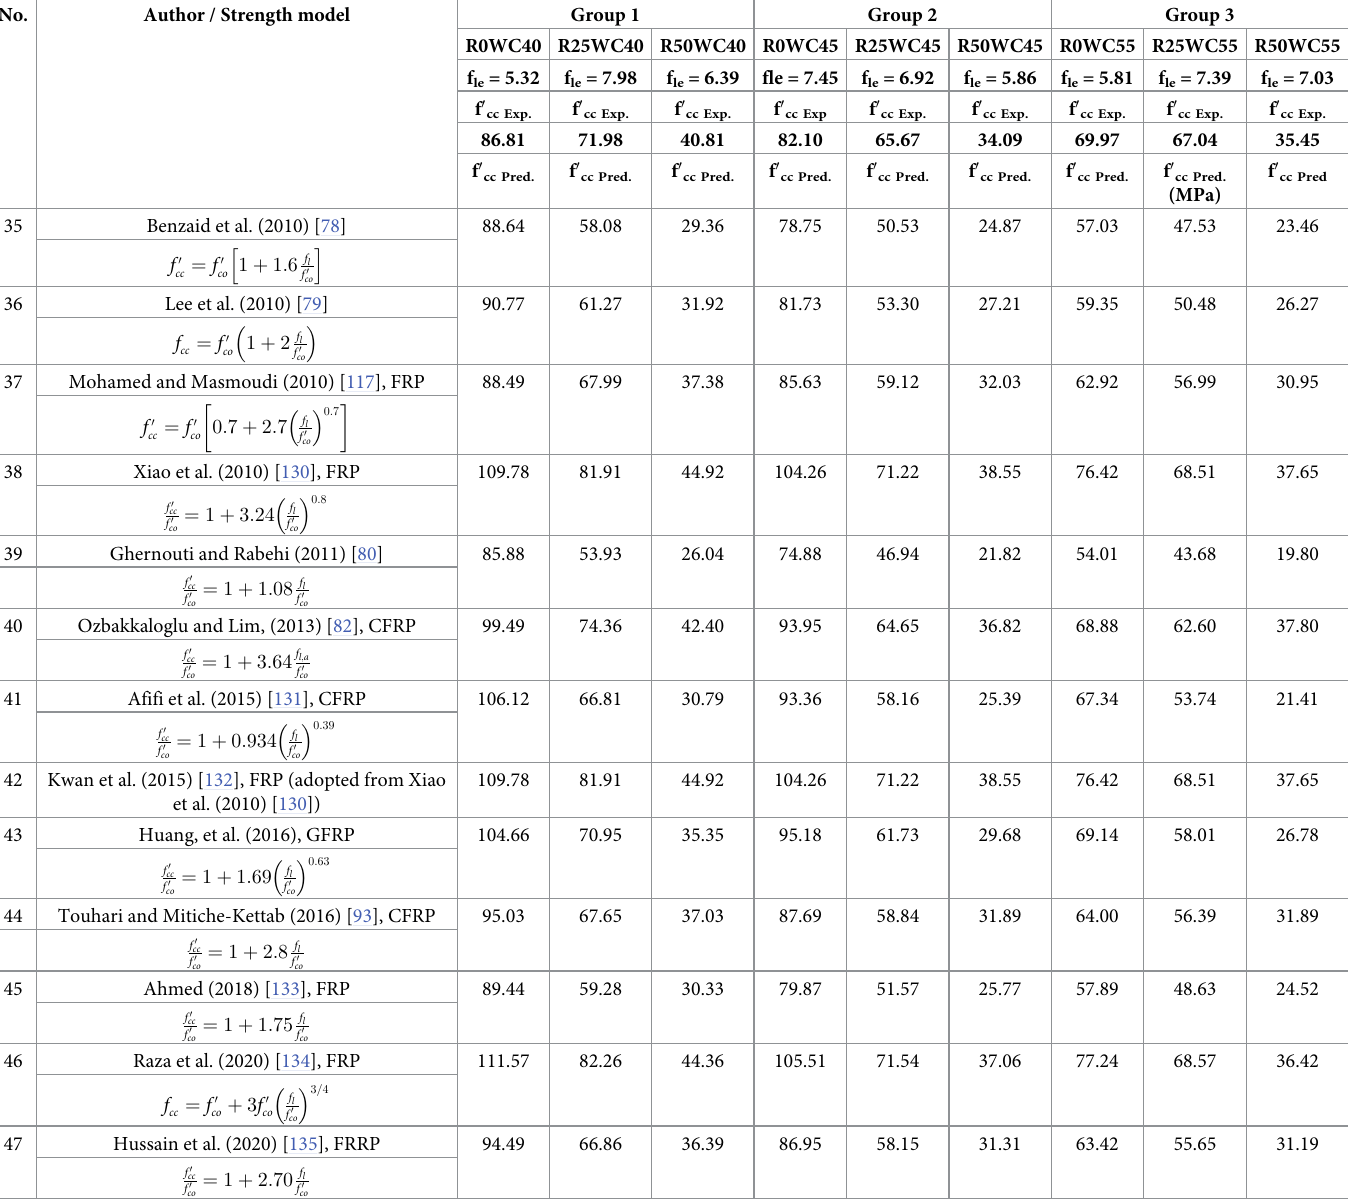
substitution. The enhancement ratio ranged from 8% to 190%. 3. For cylinders confined with CFRP, as the replacement ratio increases, there is a decrease in the initial slope of the axial -strain curve and-strain curve and the value of stress at which the stress-strain curve ceases to be linear. Note that the slope of the non-linear part of the axial stress-strain curve is always positive due to the confining pressure, which increases rapidly due to the rapid increase in lateral dilation of the